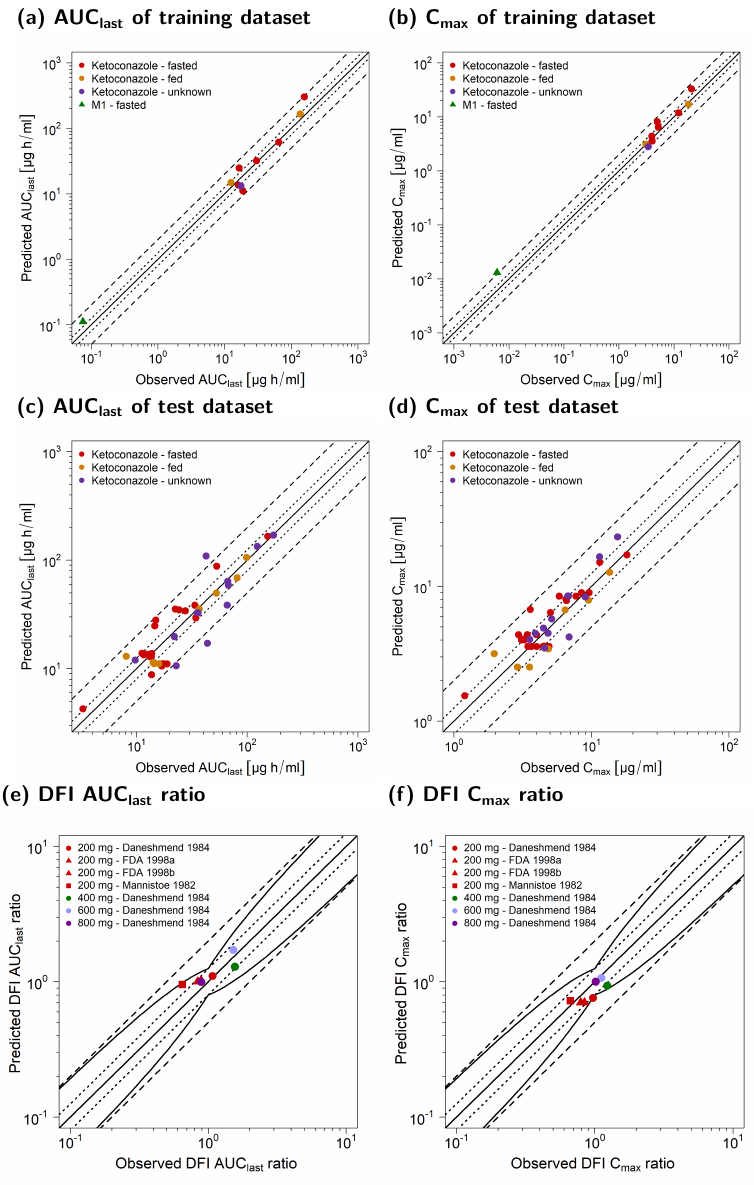
Figure 4. Goodness-of-fit plots of PK parameters for ketoconazole and M1. Predicted AUC last 1 values of the training ( a ) and test dataset ( c ) as well as C max values of the training ( b ) and test dataset ( d ) were compared to the respective observed data. Predicted (as compared to observed) DFI effect ratios of AUC last ( e ) and C max ( f ) are shown for the single doses of 200, 400, 600, and 800 mg [6,49,51]. The straight solid line marks the line of identity, dotted lines indicate 1.25-fold, and dashed lines indicate 2-fold deviation. The curved solid lines show the prediction acceptance limits proposed by Guest et al. (including 1.25-fold variability) [52]. Detailed information on the study protocols is provided in Table S1.2 in the Supplementary Materials. AUC last : area under the plasma concentration-time curve calculated from the first to the last concentration measurement; C max : maximum plasma concentration; DFI: drug–food interaction; fasted: fasted condition; fed: fed condition, M1: N -deacetylketoconazole; n: number of study participants; unknown: unknown food